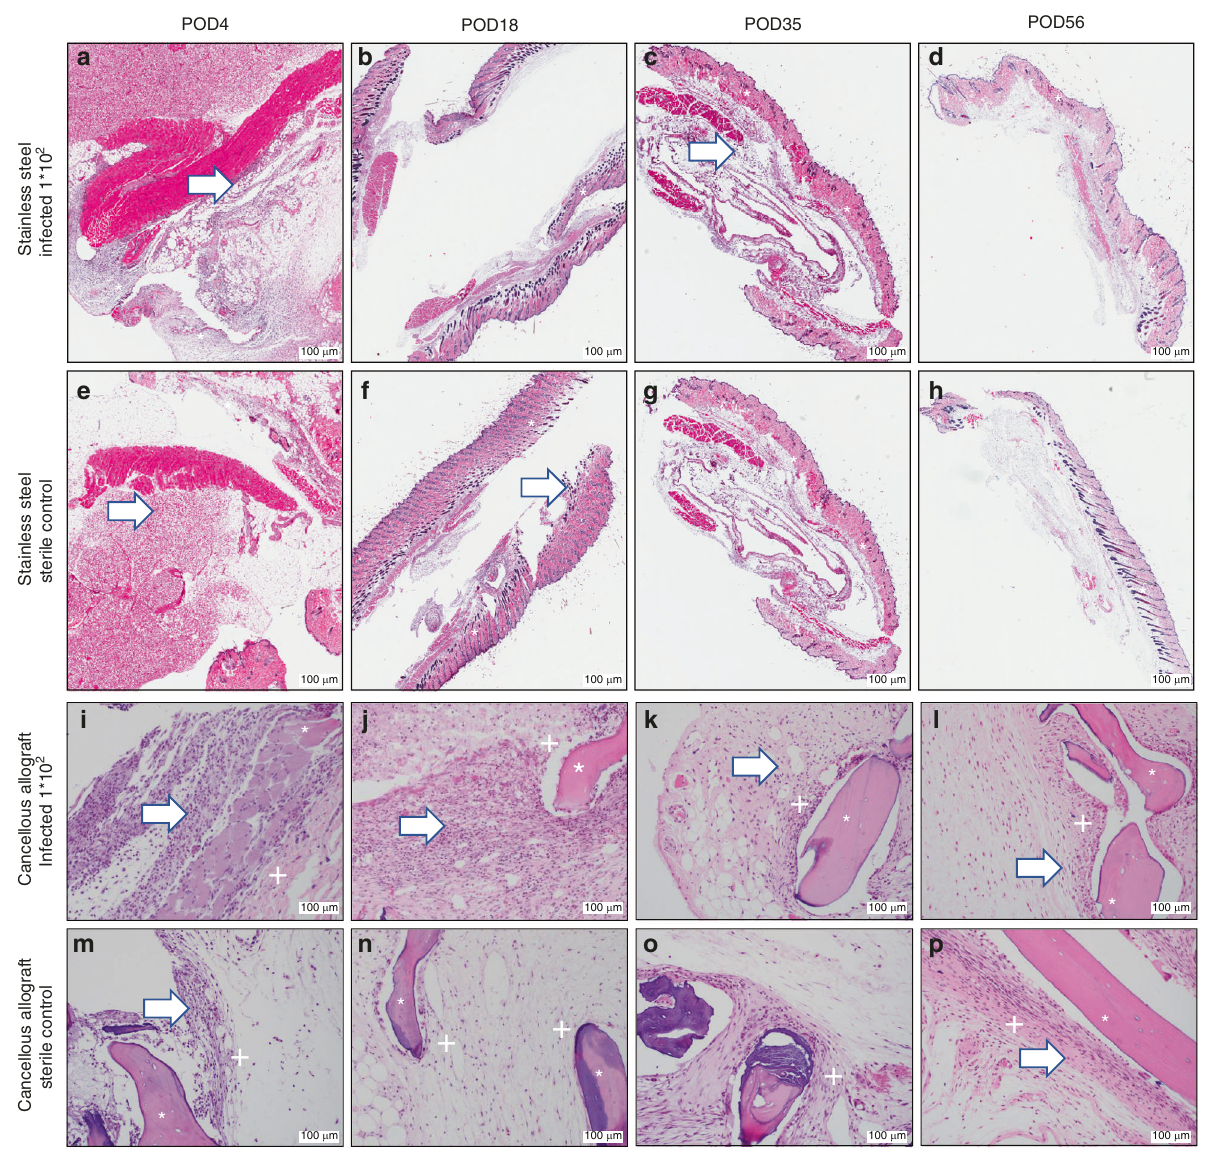
Fig. 4 Stainless steel disc and cancellous allograft histology. All images taken at ×200. a – d Inoculated with 1 × 10 2 CFU S. aureus . e – h Sterile control. a Acute in fl ammatory cells. b Acute in fl ammatory cells, no capsule. c No capsule, stroma tissue. d No capsule, stroma tissue. e Acute in fl ammatory cells. f Acute in fl ammatory cells, no capsule. g No capsule, stroma tissue. h No capsule, stroma tissue. Note in particular the presence of signi fi cant in fl ammatory cells throughout both infected and sterile specimens, but no evidence of cocci bacteria was discovered throughout. * = stromal tissue, + = capsule, white arrow = in fl ammatory cells. Cancellous allograft histology. i – l Inoculated with 1 × 10 2 CFU S. aureus . m – p sterile control. i Thin capsule surrounding cancellous bone, neutrophils. j Thin capsule surrounding cancellous bone, neutrophils. k Thin capsule surrounding cancellous bone, neutrophils. l Thin capsule surrounding cancellous bone, neutrophils and eosinophils. m Thin capsule surrounding cancellous bone, minimal acute in fl ammatory cells. n Thin capsule surrounding cancellous bone, no acute in fl ammatory cells. o Thin capsule surrounding cancellous bone. p Thin capsule surrounding cancellous bone, some eosinophils. Note in particular the presence of in fl ammatory cells throughout both infected and sterile specimens, but no evidence of cocci bacteria was discovered throughout. * = bone, + = capsule, white arrow = in fl ammatory cells, blue arrowhead = cocci